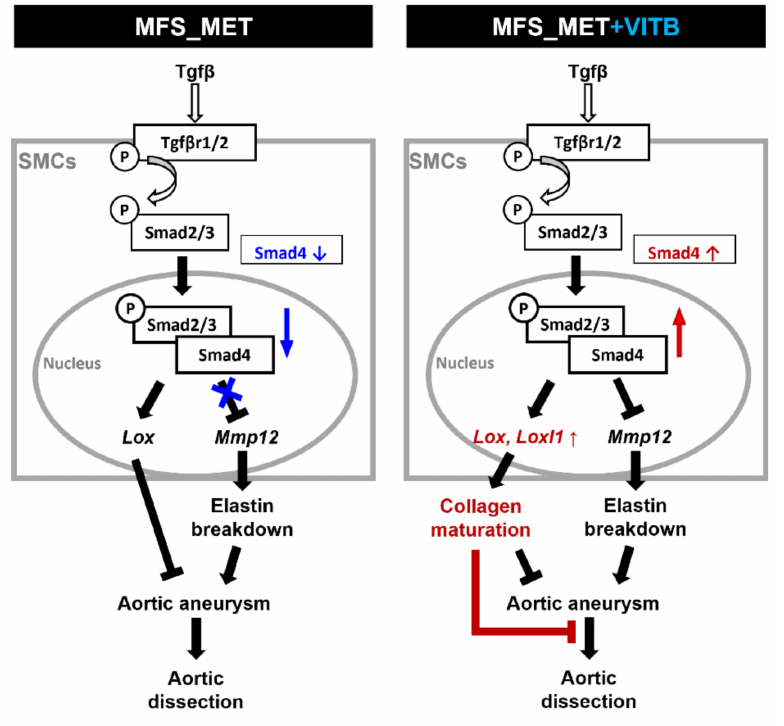
Figure 6. VITB mitigates TAA dilation in MFS mouse model. TGF- β pathway plays a central role in MFS TAA formation. The insufficiency of Smad4 results in lacking control of metalloproteinase and less ECM maturation in 6-month-old MFS mice (left). VITB treatment (right) rescued smad4 expression to the normal level and elevated lysyl oxidase expression. Collagen maturation induced by lysyl oxidases could strengthen the aortic wall and slow down the TAA dilation. Collagen maturation might provide structural integrity and protect the aorta from